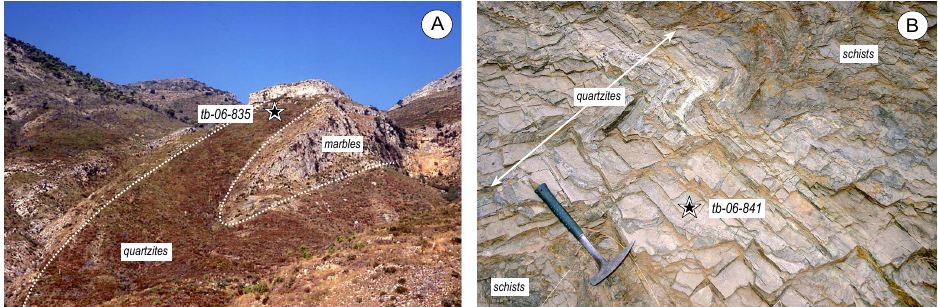
Figure 2. Outcrop views and locations of tb-06-835 ( A ) and tb-06-841 ( B ) quar tz ites.